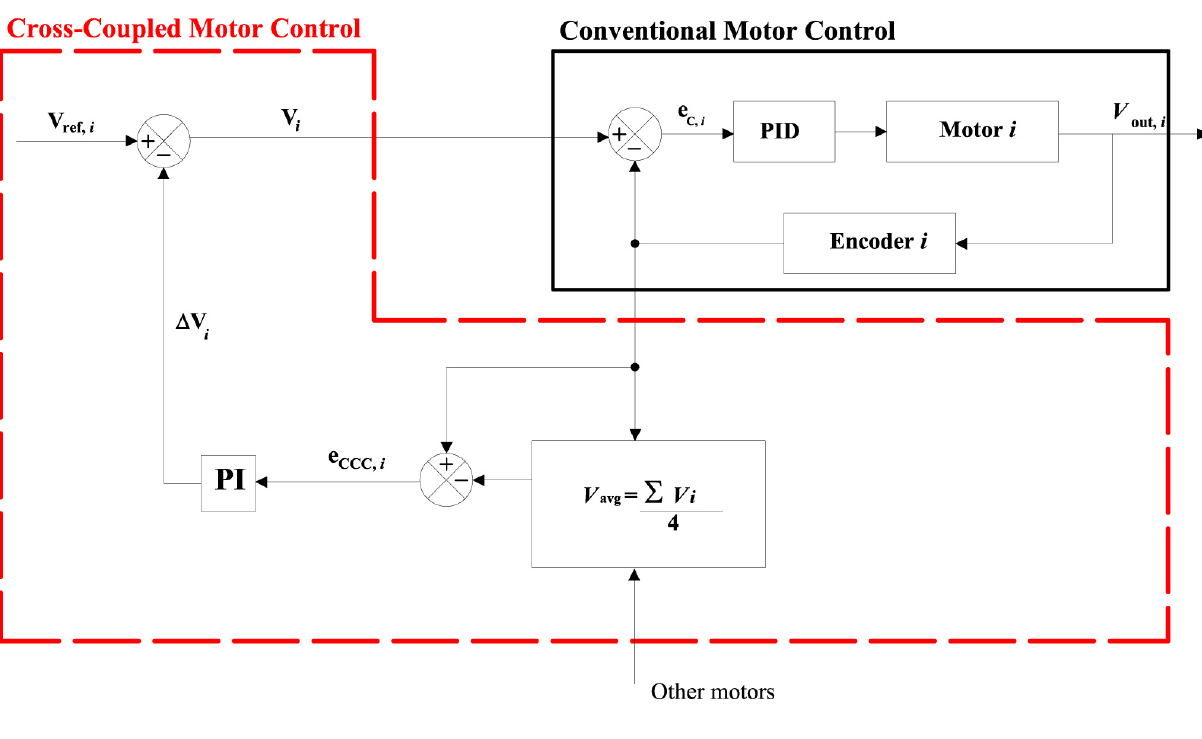
Figure 3. Block diagram of a cross-coupled control loop for the i -th wheel of the rover during straight motion. The conventional part of the control loop is denoted by a solid black line. The CCC part is outlined by a red dashed